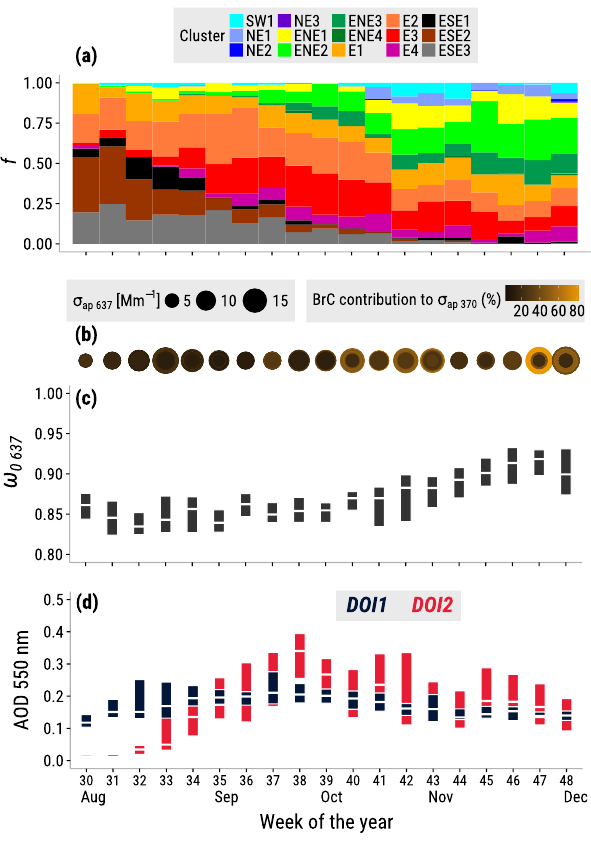
Figure 4. Multi-year (2012–2017) dry season weekly averages of (a) frequency of occurrence of BT clusters, f , (b) absorption co- efficients at 637nm, σ ap,637, shown as circles with increasing di- ameters, the color scale corresponding to the relative BrC contribu- tion to σ ap,370 , (c) single scattering albedo at 637nm, ω 0637 , and (d) aerosol optical depth at 550nm (AOD) for the different domains of interest, DOI1 and DOI2, which cover regions of the South At- lantic Ocean and the southern Amazon, respectively. Boxplots in (c) and (d) represent the median (white segment) and the 25th and 75th percentiles (lower and upper box edges,